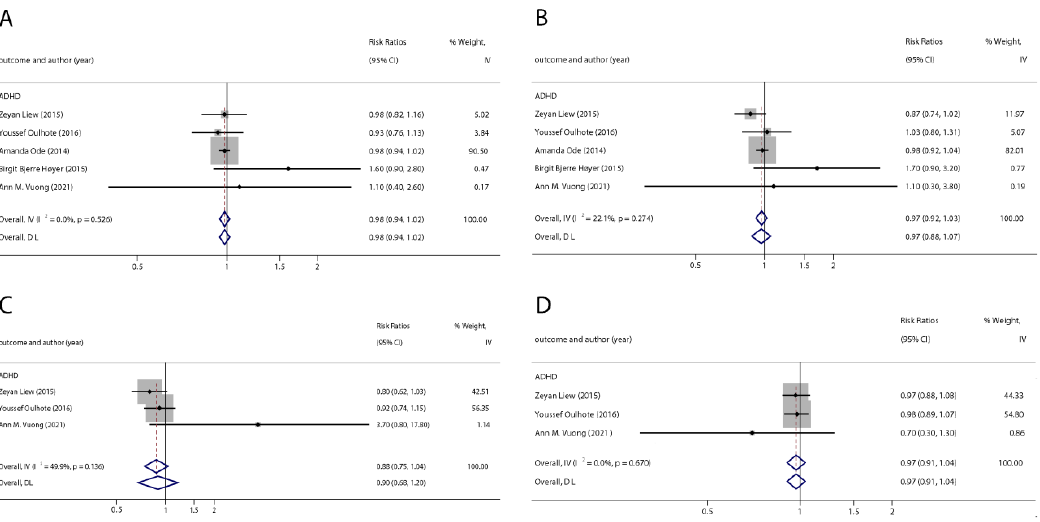
Figure 2. Pooled odds ratios for ADHD associated with per 1 ng/mL increase in polyfluoroalkyl substance concentrations. ( A ): PFOA; ( B ): PFOS; ( C ): PFNA; ( D ): PFHxS. Abbreviations: CI, confidence interval; PFOA, perfluorooctanoate; PFOS, perfluorooctane sulfonate; PFNA, perfluorononanoate; PFHxS, perfluorohexane sulfonate; ADHD: attention deficit hyperactivity disorder [42,44,46,47,50].